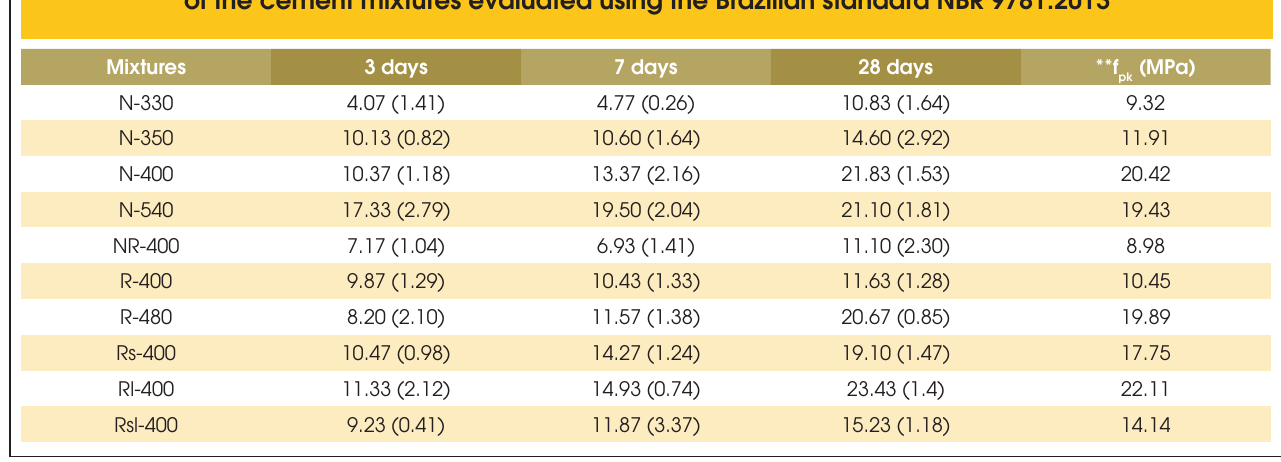
) and standard pk